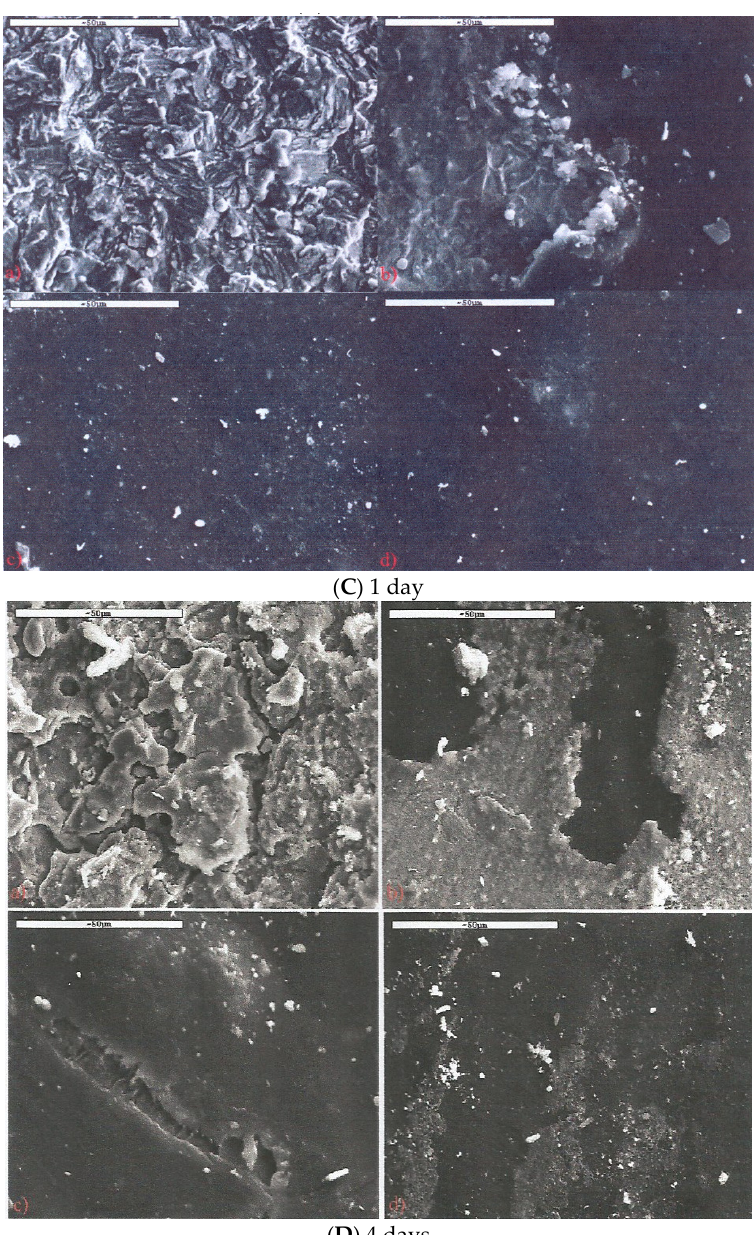
Figure 8. Scanning electron micrographs of initial (no exposure) ( A ), cross section of steel coated with I.30E ( B ), and salt spray tested specimens after 1 day ( C ) and 4 days ( D ) of exposure in a corrosive environment of 100% saturated moisture + 5 wt % NaCl solution: (a) bare steel; (b) coated with pristine resin; (c) coated with I.28E nanocomposite; (d) coated with I.30E